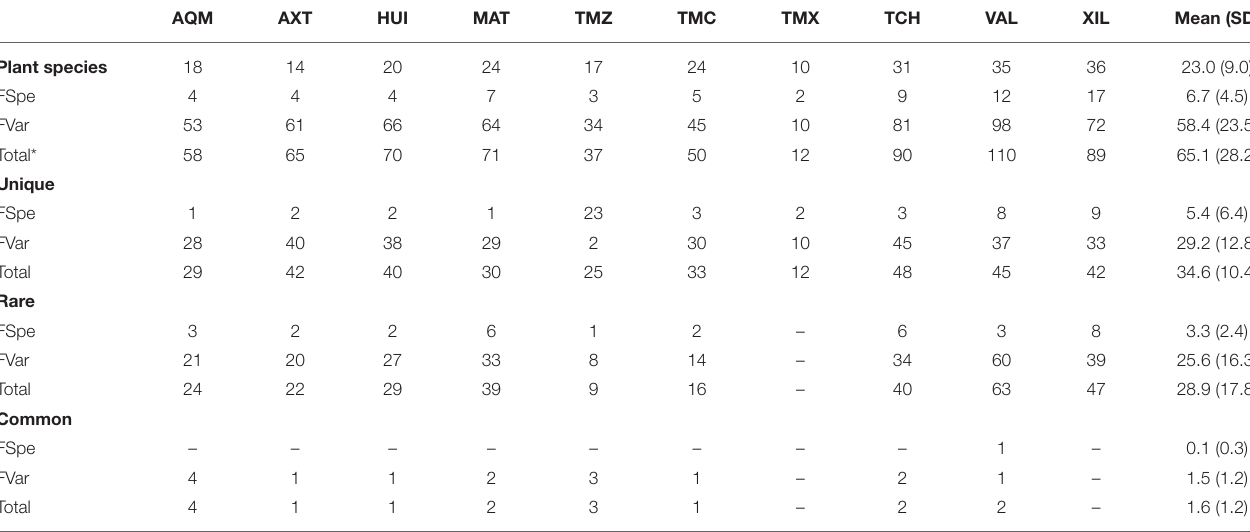
TABLE 3 | Distribution of the food plant species useful for propagation in the markets in the Huasteca